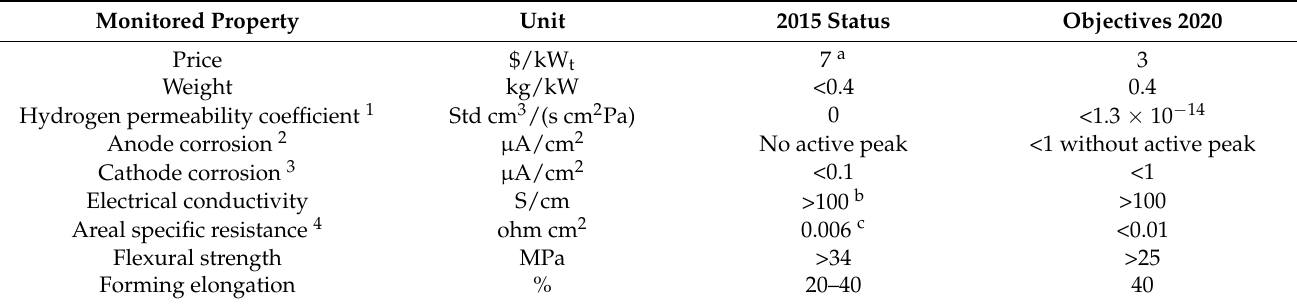
Table 1. Requirements for bipolar plates for vehicles